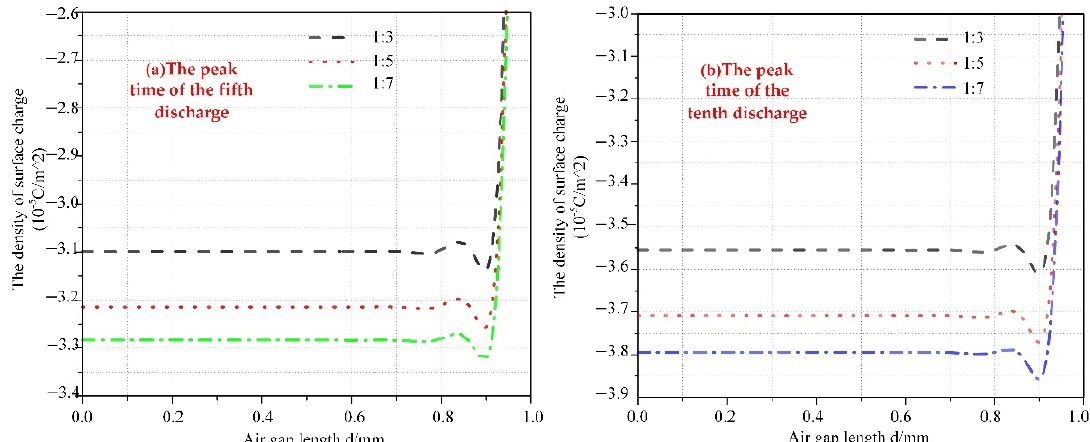
Figure 4. The density of surface charge at the fifth and the tenth discharge peak. ( a ) The peak time of the fifth discharge. ( b ) The peak time of the tenth discharge.